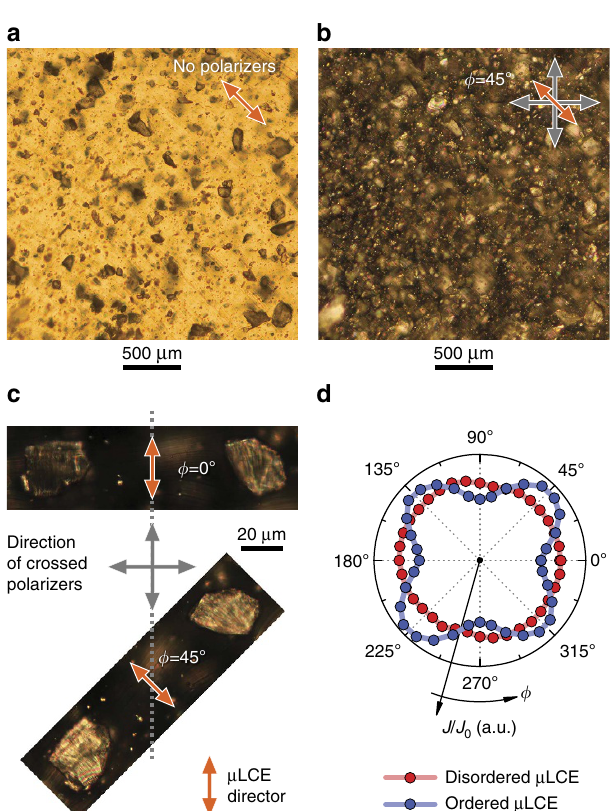
Figure 3 | Structure of PDLCE as seen under polarizing optical microscope. ( a ) Without polarizers, the isotropic matrix transmits light, whereas LCE microparticles are seen as dark spots. ( b ) Under crossed polarizers, the light passing through the matrix is blocked, whereas LCE microparticles do transmit light due to their anisotropic nature. ( c ) Two microparticles compared at different orientations with respect to polarizers. The particles are dark when their directors are aligned with one of the polarizers ( f ¼ 0 (cid:2) ) and bright at f ¼ 45 (cid:2) . PDLCE-A sample, cut into 0.1mm thick slice, with low, 5%wt concentration of m LCE-A , was used for microscopy investigations. ( d ) Polar plot of the sample’s transmittance J / J 0 demonstrating the optical anisotropy of the aligned (ordered) sample, arising from the alignment of m LCE